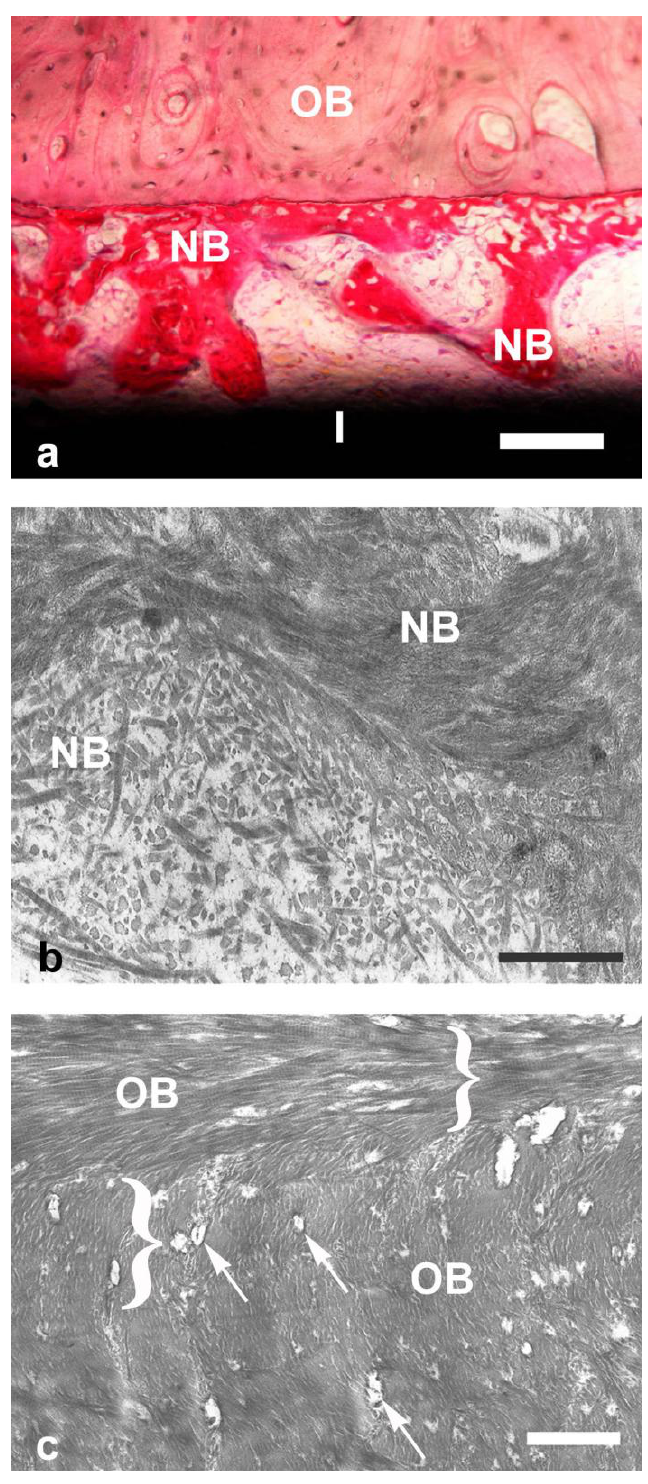
FIGURE 3. LM-TEM correlative analysis of the osteointegration process 4 weeks after implant insertion. (a) Section of a bone-implant sample observed by LM. Trabeculae of newly formed bone tissue (NB) can be seen at the interface forming a network within the bone- implant gap. I = implant; OB = pre-existing bone. (LM, bar = 100 μm). (b) Newly formed bone tissue (NB) at the bone-implant interface from the same section area shown in Fig. 3a after deacrylation of the section, implant removal, and bone processing for TEM. Note the organization of the more recently formed bone tissue with disorderly arranged collagen fibrils loosely distributed in the extracellular matrix. (TEM, bar = 1 μm). (c) Mature lamellar bone tissue (OB) from the same section area shown in Fig. 3a after deacrylation of the section, implant removal, and bone processing for TEM. Note the parallel orientation of collagen fibrils, strictly bundled together into bone lamellae, and their different orientation in two adjacent lamellae (brackets). Also note the osteocyte canaliculi containing cell extensions in transverse section (arrows). (TEM, bar = 1